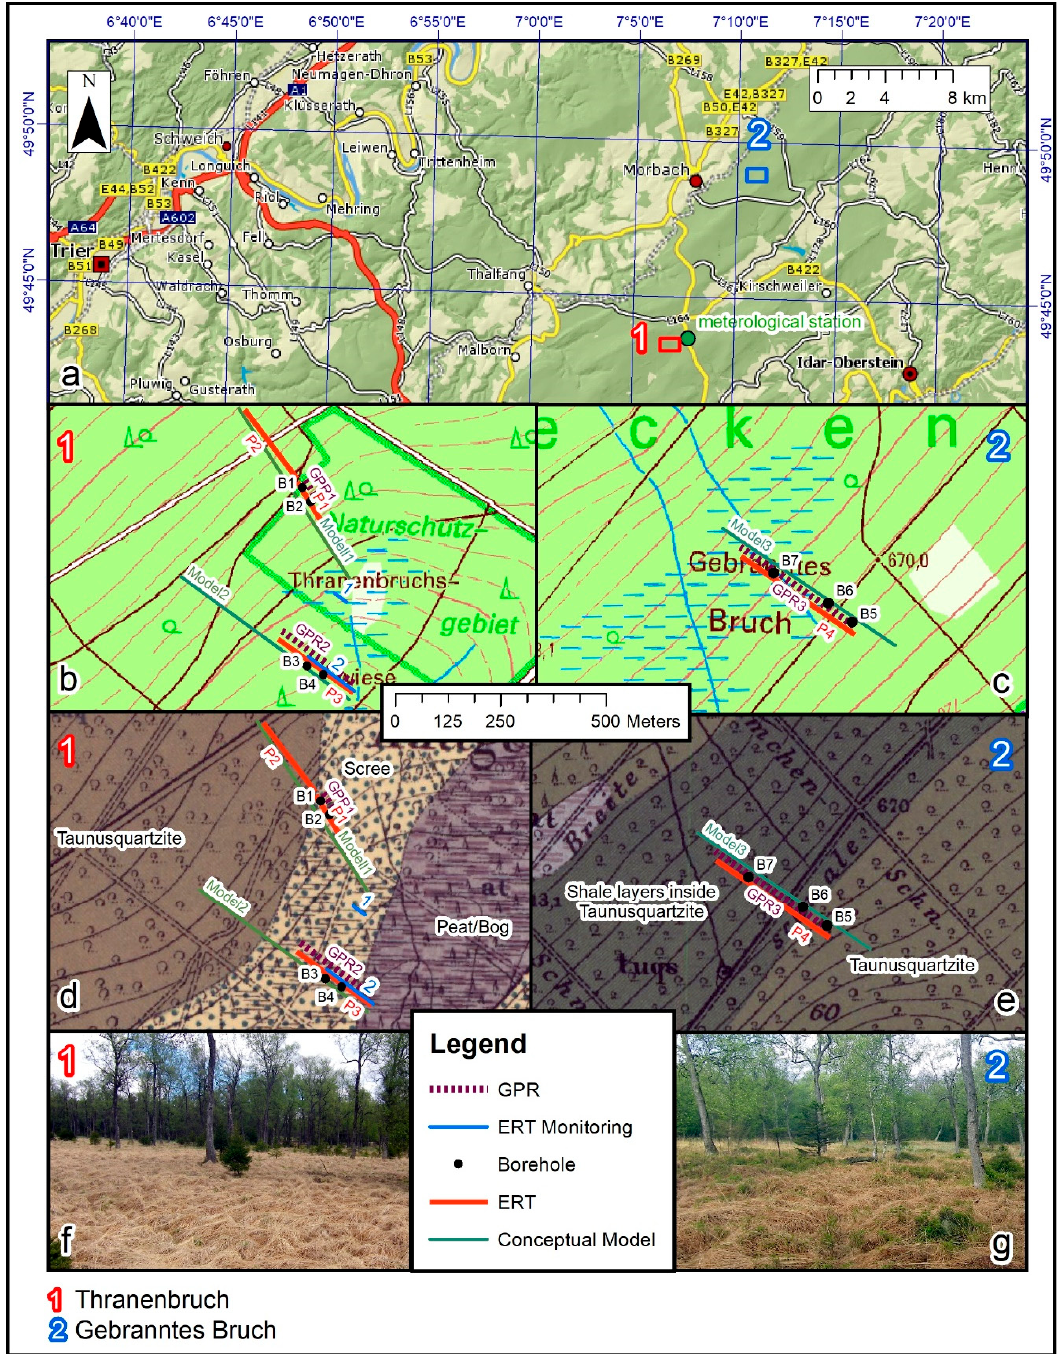
Figure 1. Location of the study sites: ( a ) overview (Basemap: Esri-basemap-Topographic-10 October 2018), ( b ) profile of “Thranenbruch” (Basemap: TK 25, 6208, Morscheid-Riedenburg), ( c ) profile of “Gebranntes Bruch” (Basemap: TK 25, 6109, Hottenbach), ( d ) geological map of “Thranenbruch” (Basemap: GK 25, 6208, Morscheid), ( e ) geological map of “Gebranntes Bruch” (Basemap: GK 25, 6109, Hottenbach), ( f ) photograph of “Thranenbruch”, ( g ) photograph of “Gebranntes Bruch”.